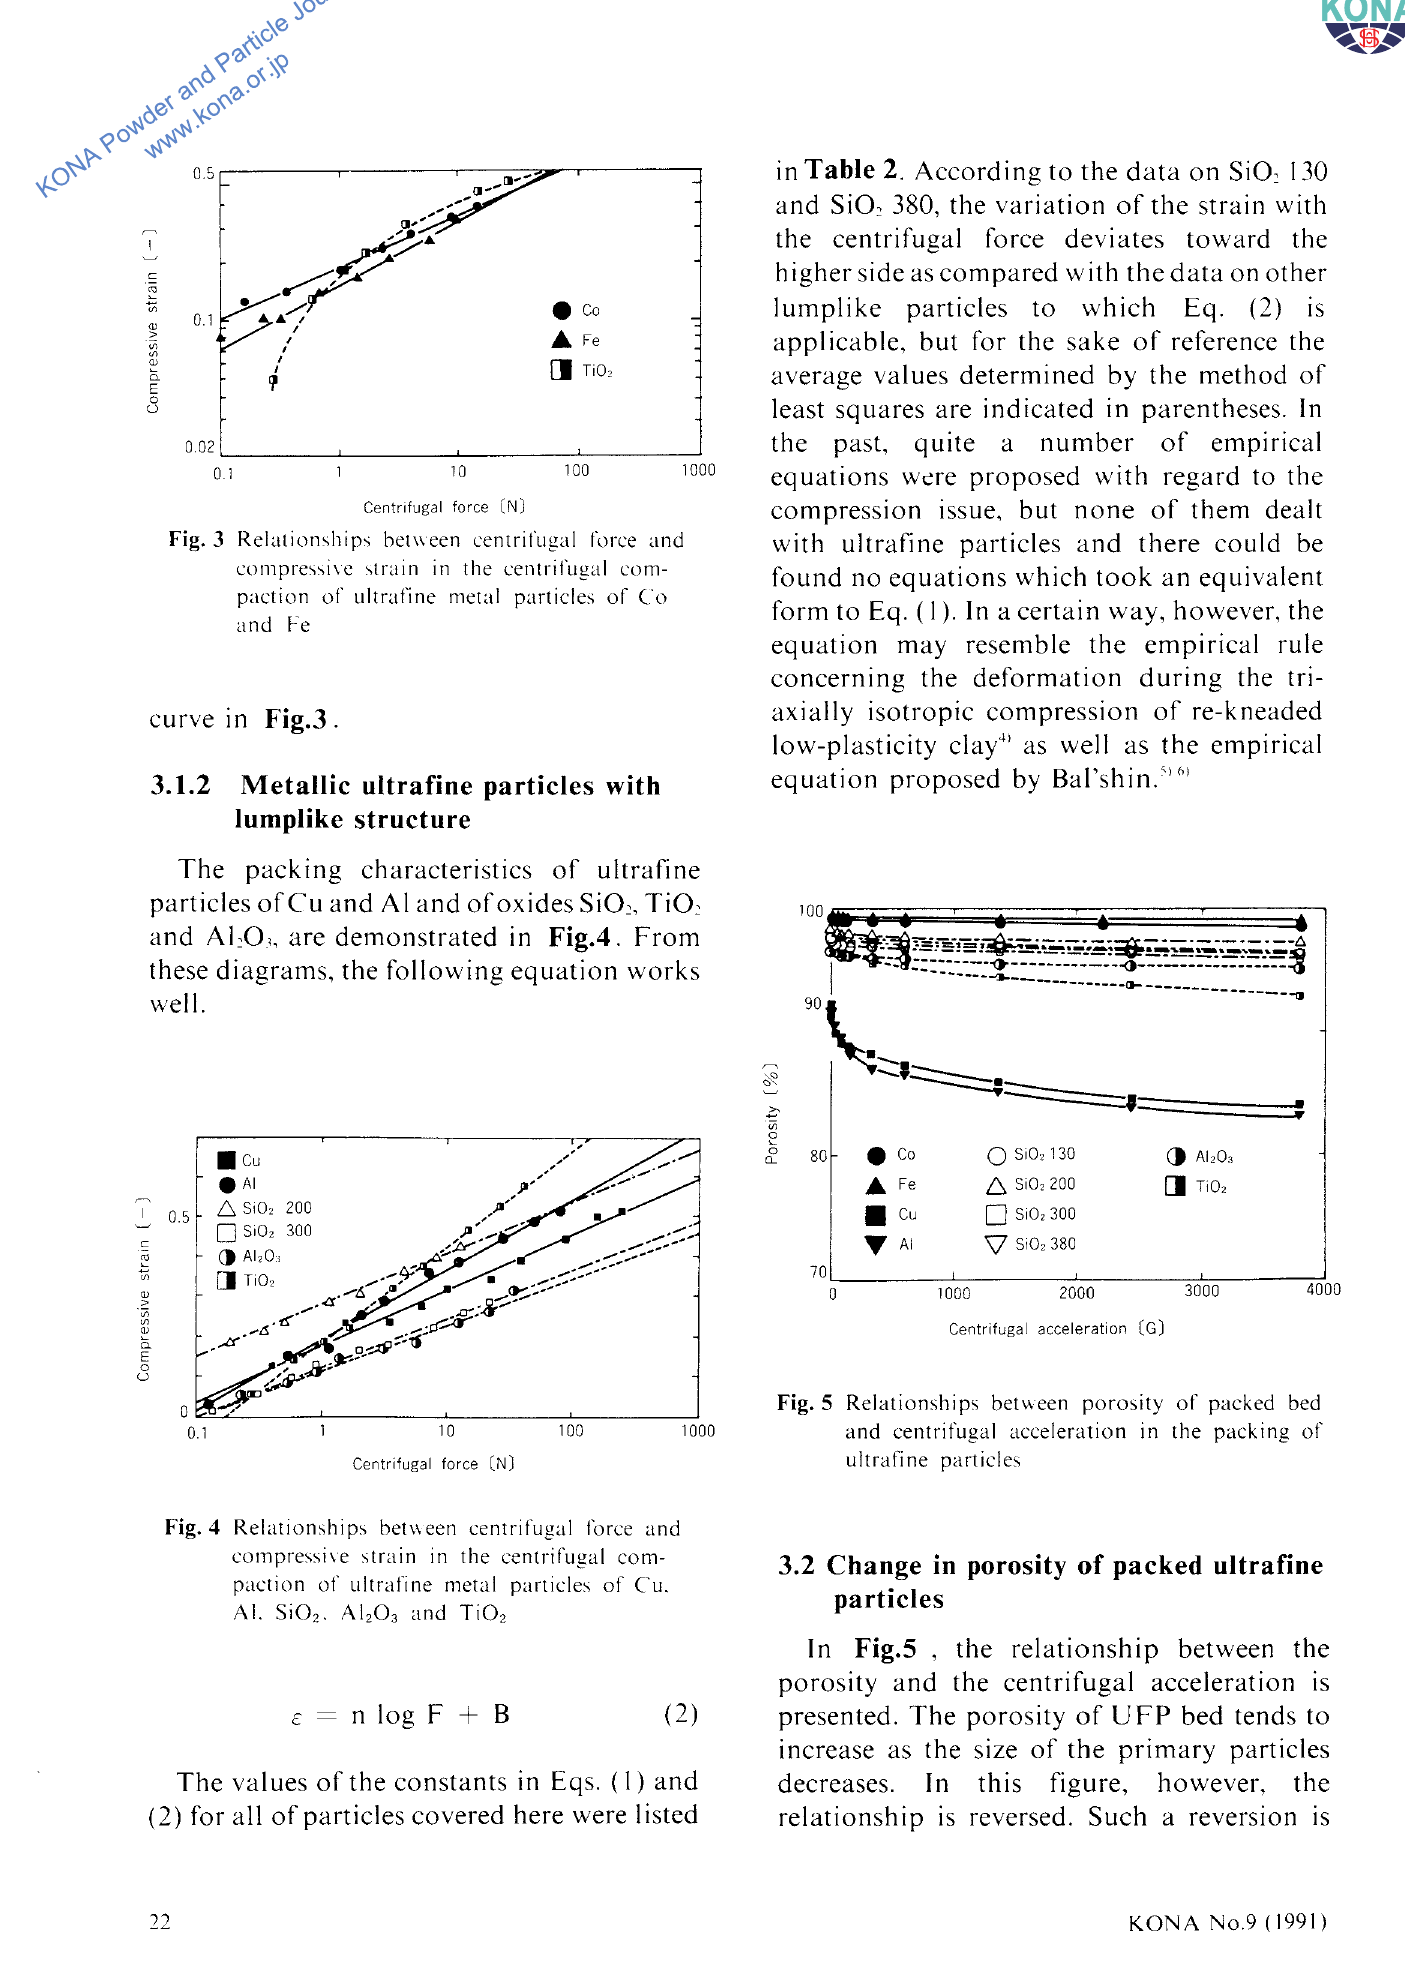
Fig. 4 Relationships het\\een centrifugal force and compressive strain in the centrifugal com paction of ultrafine metal particles of Cu.